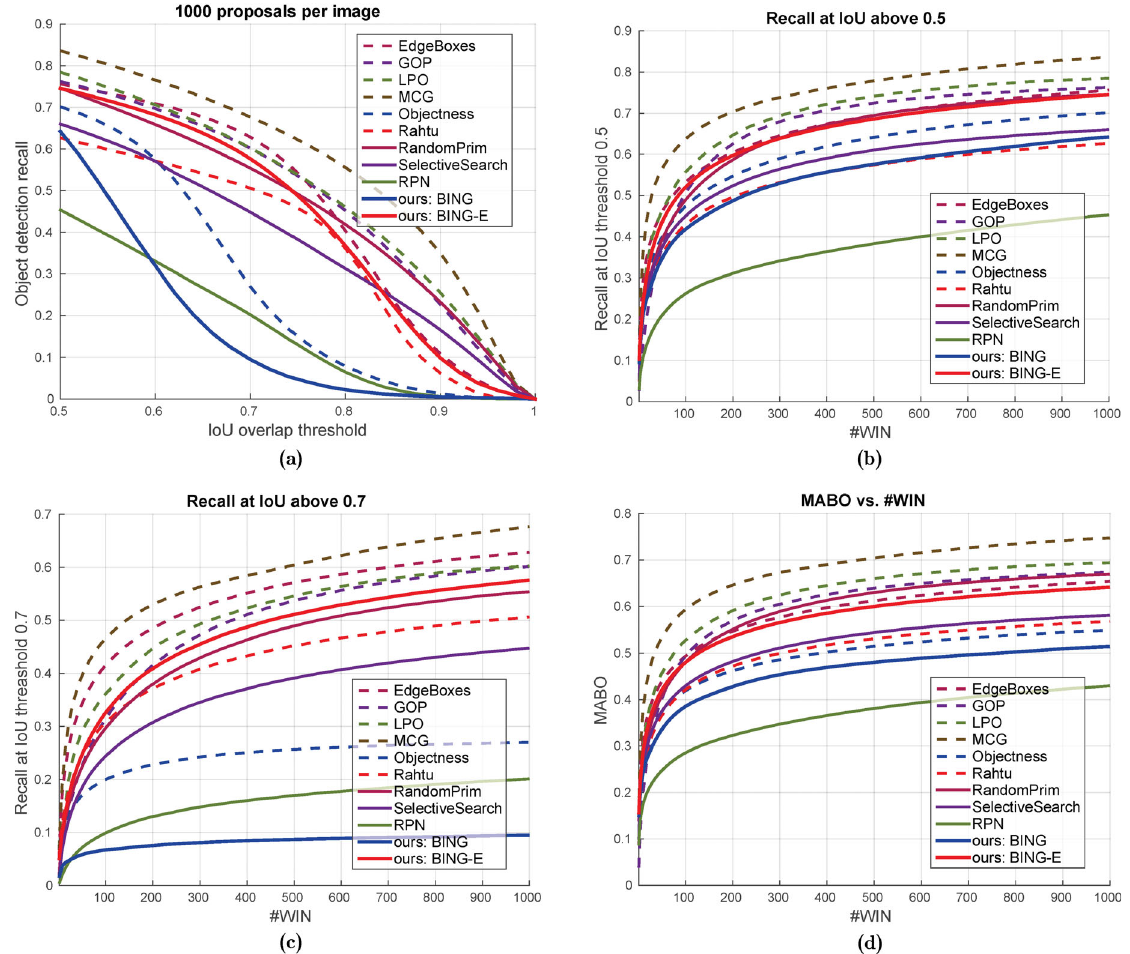
Fig. 6 Testing results on COCO validation dataset: (a) object detection recall versus IoU overlap threshold; (b, c) recall versus number of candidates at IoU thresholds 0.5 and 0.7 respectively; (d) MABO versus the number of candidates using at most 1000